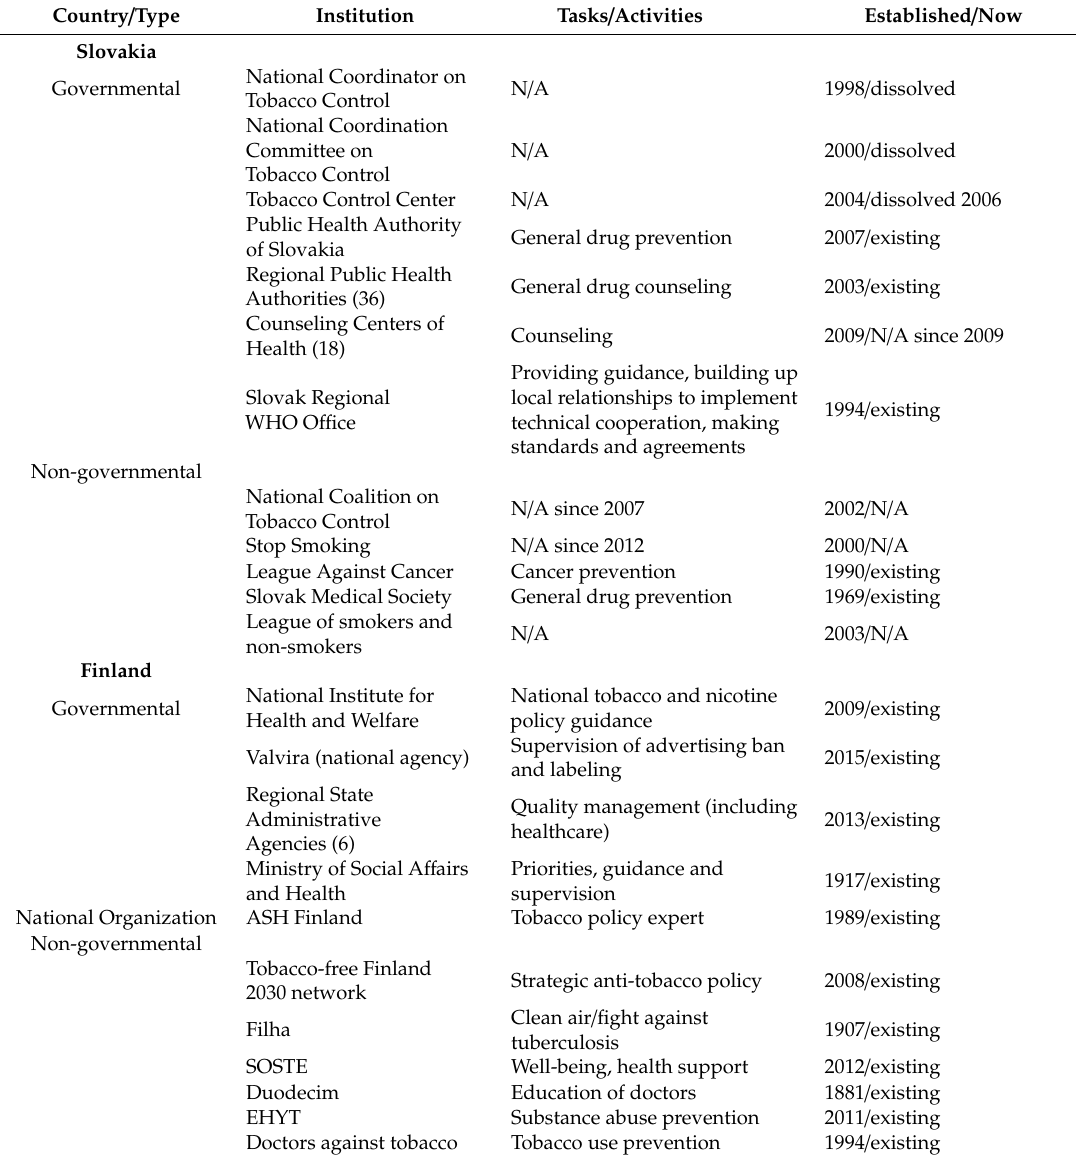
Table 1. Slovakian and Finnish institutional frameworks for tobacco control policy (governmental and